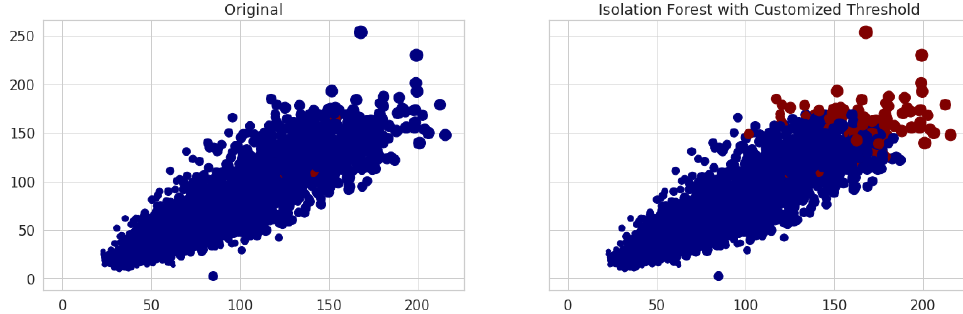
Figure 8. Original Dataset ( left ) versus Isolation Forest Predictions ( right